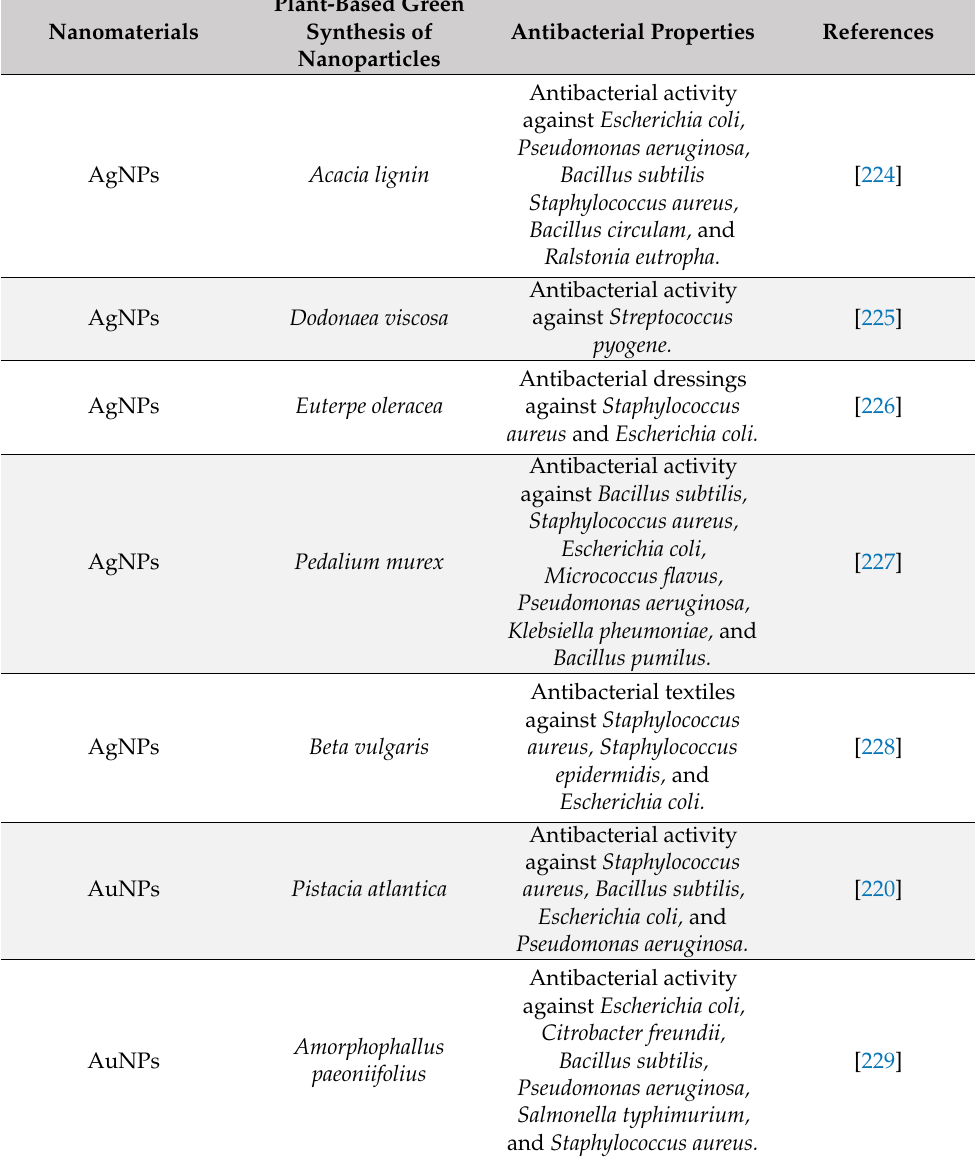
Table 3. Examples of plant-based green synthesis of nanoparticles with antibacterial